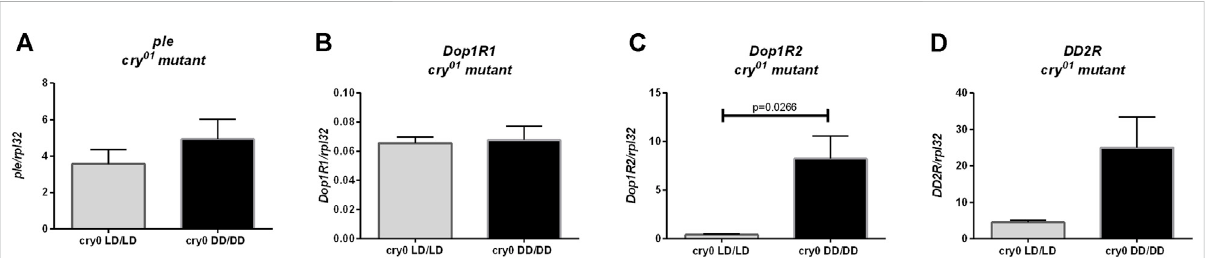
Light during early life affects only one of dopamine receptors in cry 01 mutant fl ies. qPCR analysis of expression level of genes connected with dopamine signaling for fl ies maintained in normal conditions LD12:12 (LD/LD), maintained in DD and developed in darkness (DD/DD). Expression